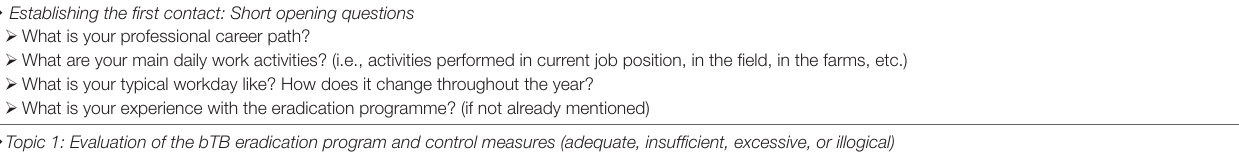
TaBle 2 | Thematic guide (topics and example questions) used in the qualitative semi-structured in-depth interviews aimed at gaining detailed information on perceptions and opinions of farmers and veterinarians about the bovine tuberculosis (bTB) eradication programme in